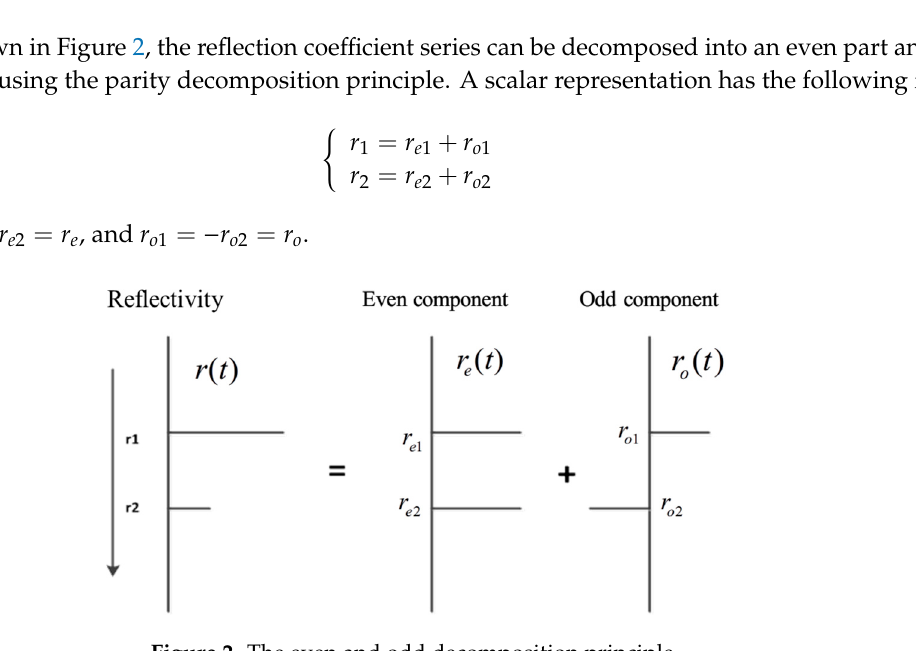
Figure 2. The even and odd decomposition principle.